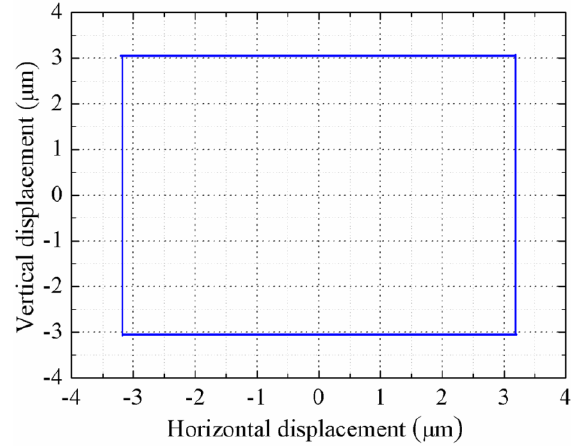
Figure 6. Motion trajectory of the driving foot.